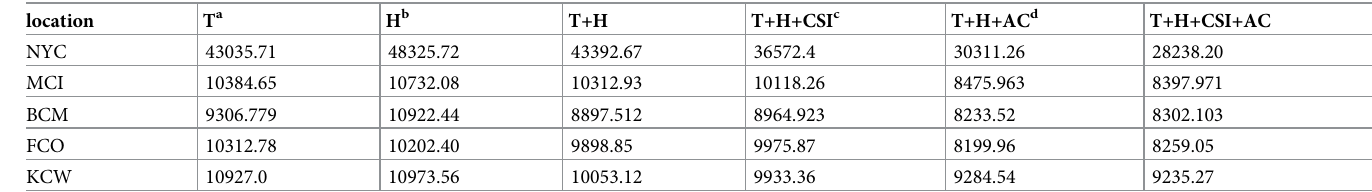
Table 3. QAIC values according to nested models with temperature and humidity plus confounders. location